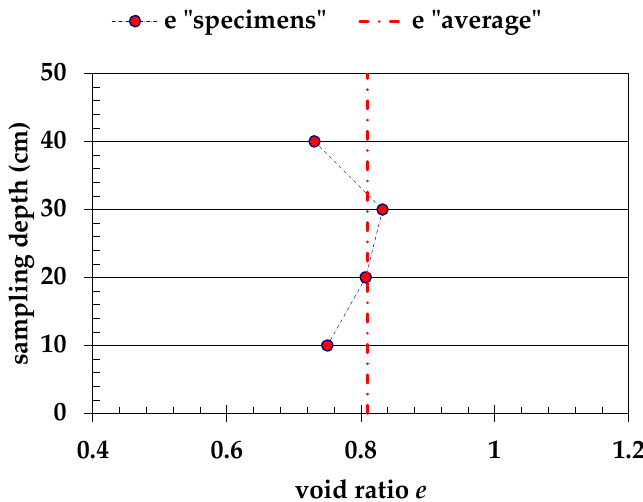
Figure 6. Vertical profile of the voids ratio and its average value within the physical model.